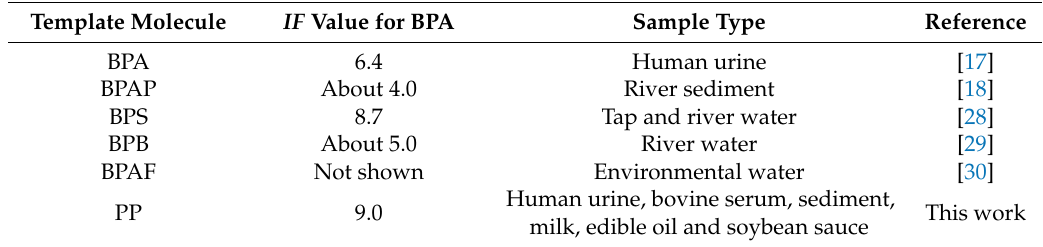
Table 1. Comparison of the prepared phenolphthalein imprinted polymer (PPMIP) in this work with other MIPs for the solid-phase extraction (SPE) of BPA in various